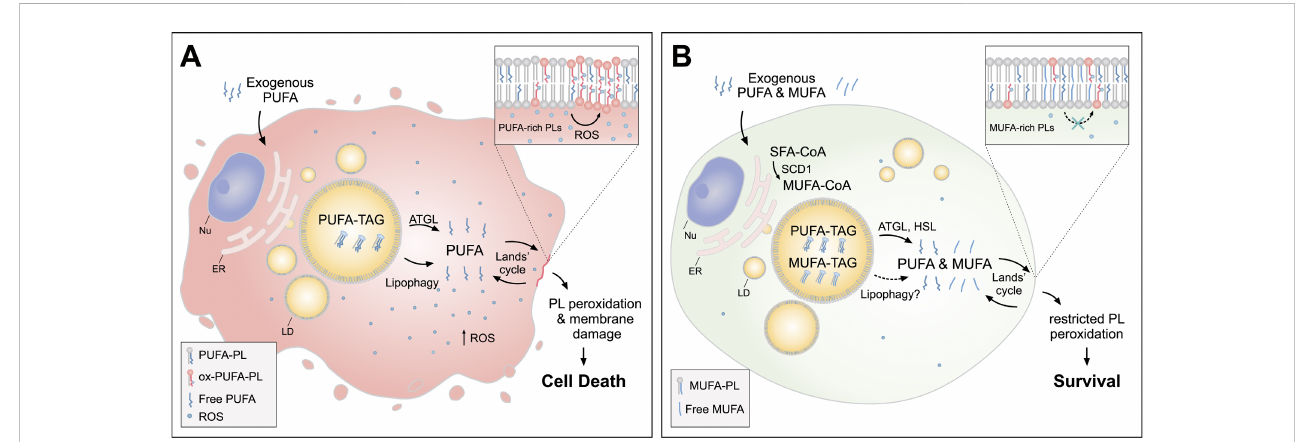
FIGURE 3 Lipiddroplets(LDs)releaseMUFAstoprotectcellsfromlipidperoxidationandcelldeath. (A) IncellsloadedwithexogenousPUFAs,thebiogenesisofLDs enriched with PUFA-TAGs is increased. Under these conditions, lipolysis via ATGL and lipophagy mediate the transfer of PUFAs from LDs to membrane phospholipids (PUFA-PLs), thereby increasing lipid peroxidation and oxidative stress, which can lead to cell death. (B) When MUFAs are added simultaneously with PUFAs orsynthesizedbythecell via SCD1, LDare enriched inboth species. Inthiscase, lipolysis via ATGL and HSL (andlikely also lipophagy)liberate both MUFAs and PUFAs from LDs, feeding a more balanced FA mixture for phospholipid acyl chain remodeling pathways (the Lands ’ cycle), leading to a reduced abundance of oxidizable PUFAs in membranes and restricted lipid peroxidation. Cofactors and by-products are omitted. ATGL: adipose triglyceride lipase; ER: endoplasmic reticulum; HSL: hormone sensitive lipase; MUFA: monounsaturated fatty acid; Nu: nucleus; Ox: oxidized; PL: phospholipid; PUFA: polyunsaturated fatty acid; ROS: reactive oxygen species; SCD1: stearoyl-CoA desaturase 1; SFA: saturated fatty acid; TAG: